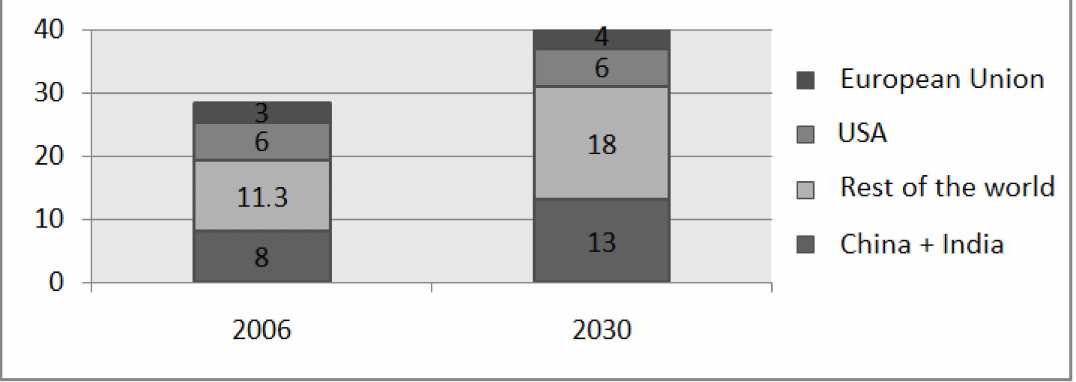
Figure 2. CO 2 emissions (billion tons). Source: Ernst & Young, 2016; Enerdata [51], Global Energy Statistical Yearbook 2018